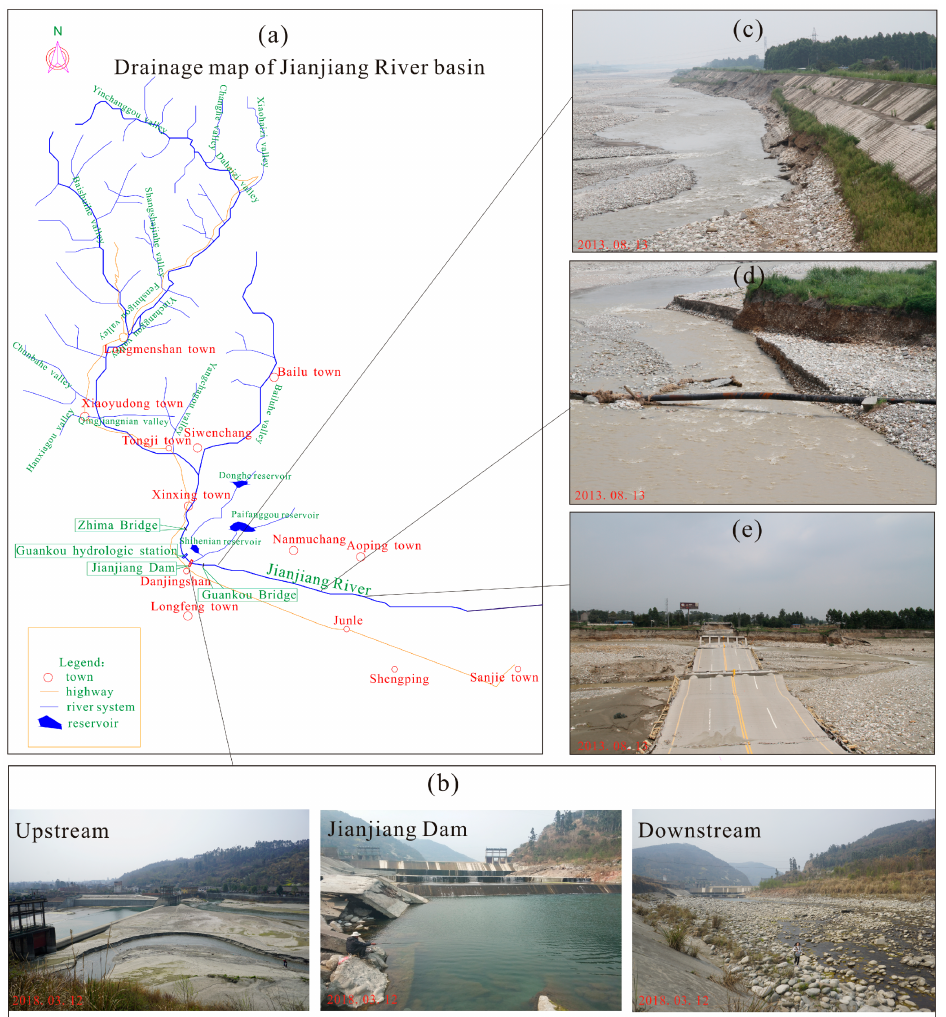
Figure 1. Situations of the field study area: ( a ) Sketch drainage map of the studied rivers; ( b ) pictures of Jianjiang Dam, where the reservoir is silted up by finer sediments upstream, whereas clear water sluices over the dam and dramatic erosion occur downstream leading to an armored layer on the riverbed; ( c ) a picture of embankment failure because of scouring; ( d ) a picture of underwater pipeline exposure due to streambed undercutting; and ( e ) a picture of bridge destruction as a result of pier